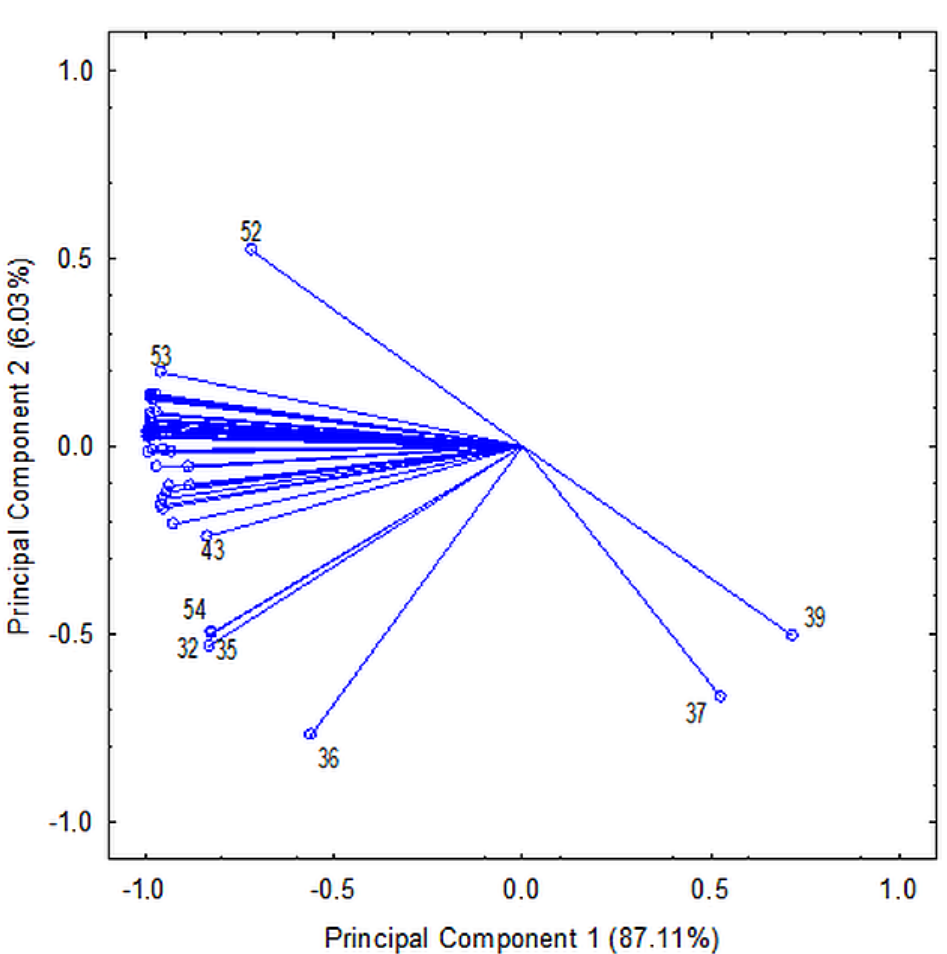
Figure 4 . Score plot of wine samples on the PCA plane defined by the first two principal components (R1-R5 wines: 1–10, R1 LAB–R5 LAB wines: 11–20, Z1-Z5 wines: 21–30, Z1 LAB–Z5 LAB wines: 31– 40; see Table 1 for phenolic compounds names) .